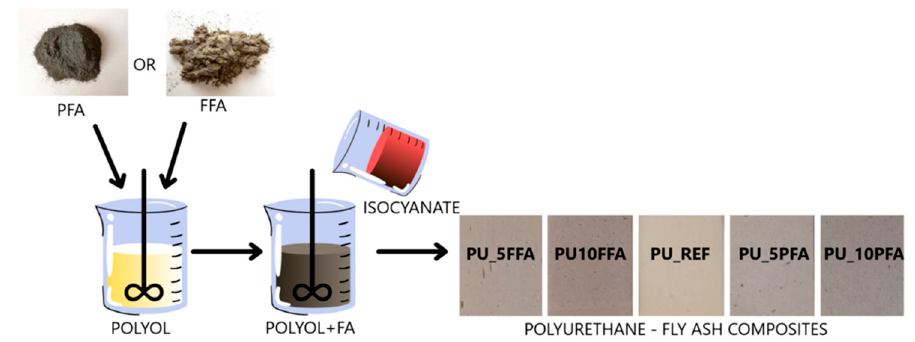
Figure 9. Scheme of the synthesis of polyurethane foam with fly ash (FFA, PFA).